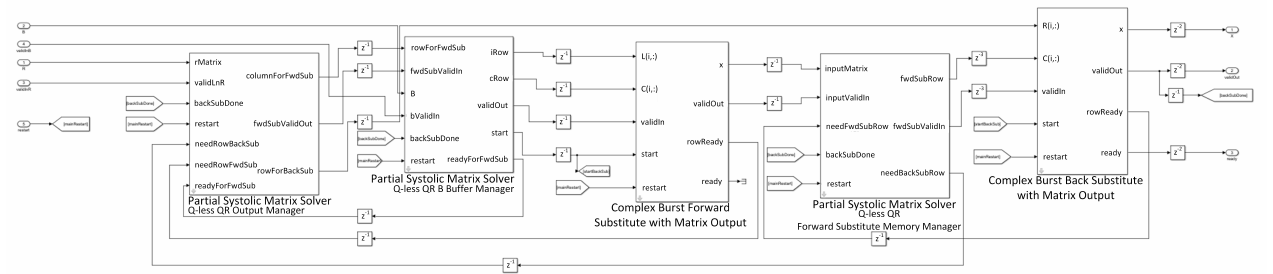
Figure 5. A demonstration of the complex Q-less QR forward-backward substitute on the FPGA board. In this work, Quadratic programming (QP) has been employed for solving the QS-SVM